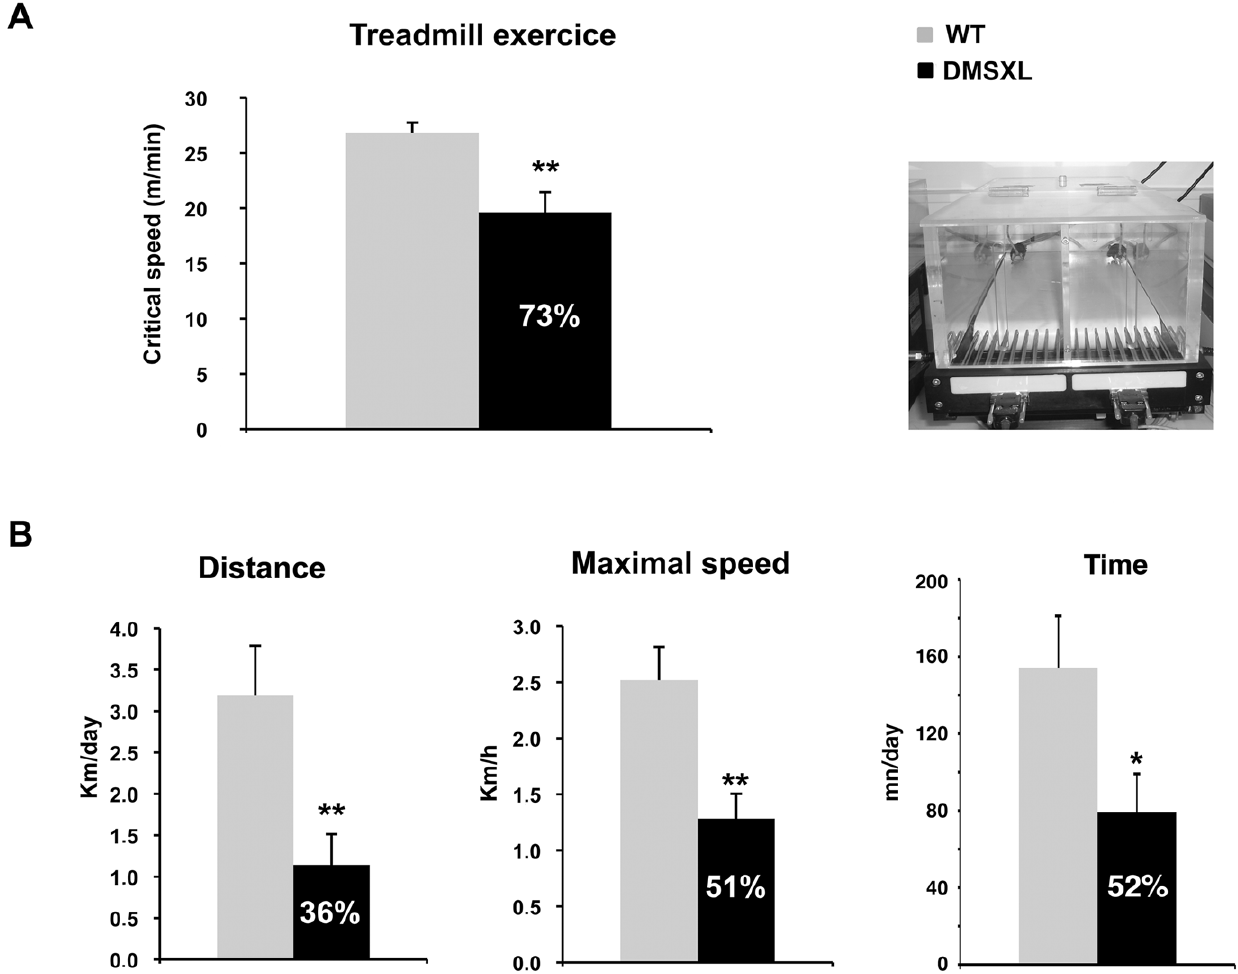
Figure 12. Motor performance of DMSXL mice. (A) Treadmill test was performed on WT and DMSXL female mice between 4 and 6 months of age. The Critical Speed was calculated from the slope of the regression line, plotting the distance versus the time to exhaustion, n=9 for both groups. (B) The wheel running test was performed on WT and DMSXL mice between 4 and 6 months of age. The mice were followed over a period of 10 days. The distance, the maximal speed and the time spent running are shown, n=14 biological replicates for both groups. Data are presented as means 6 SEM (* p , 0.05, ** p , 0.01, Student’s t test or Mann-Whitney test).